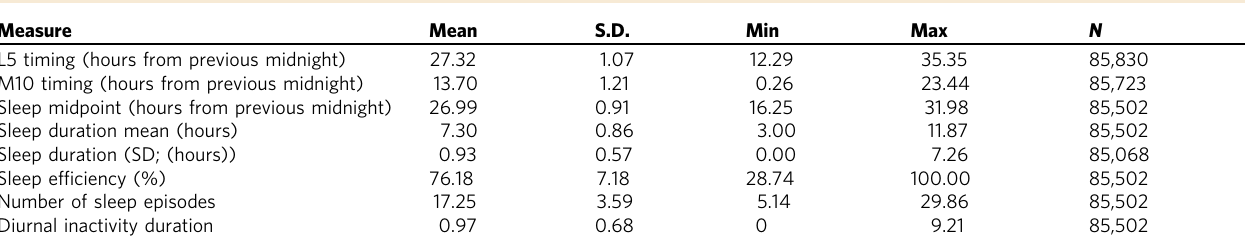
Table 1 Descriptive statistics of sleep and activity measures derived from accelerometer data Measure Mean S.D. Min Max N L5 timing (hours from previous